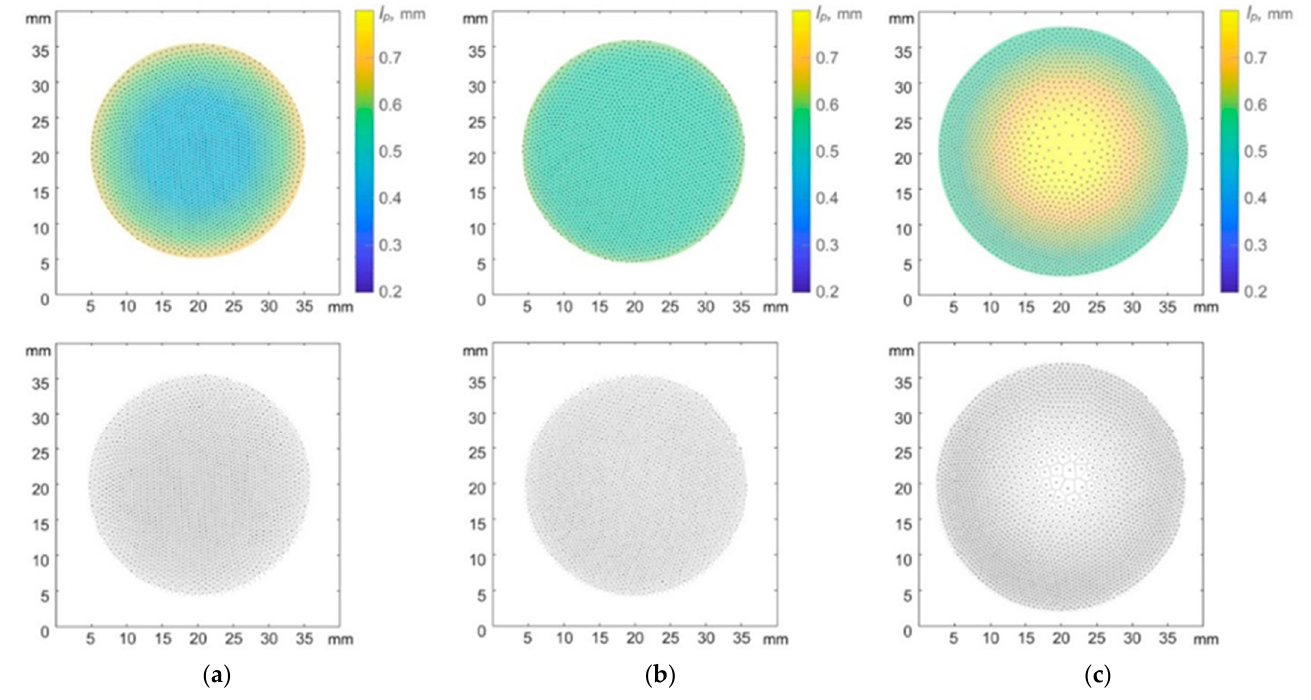
Figure 4. Quasi-two-dimensional dust structures in argon plasma of RF discharge at W = 13.1 W and various values of argon pressure P: ( a ) 3 Pa, ( b ) 4 Pa, ( c ) 5 Pa. Color bar shows radial distribution of interparticle distances (upper row), Voronoi diagrams (lower row) represent different degrees of structure inhomogeneity.